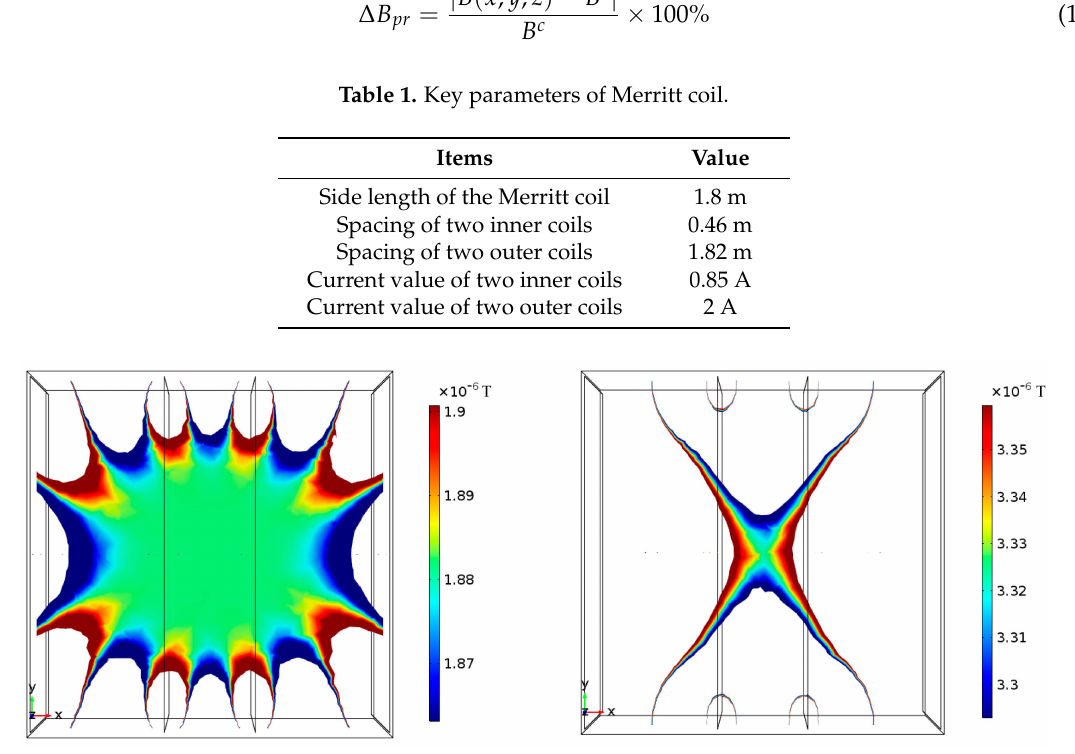
Figure 1. Flux density deviation rate less than 1% from the center are displayed: ( a ) xoy plane of Merritt coil; and, ( b ) xoy plane of Merritt coil inside the cubic magnetic